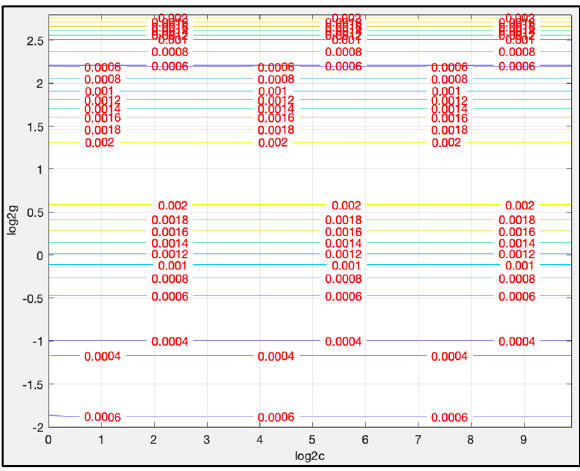
Figure 12. Results of fine selection.